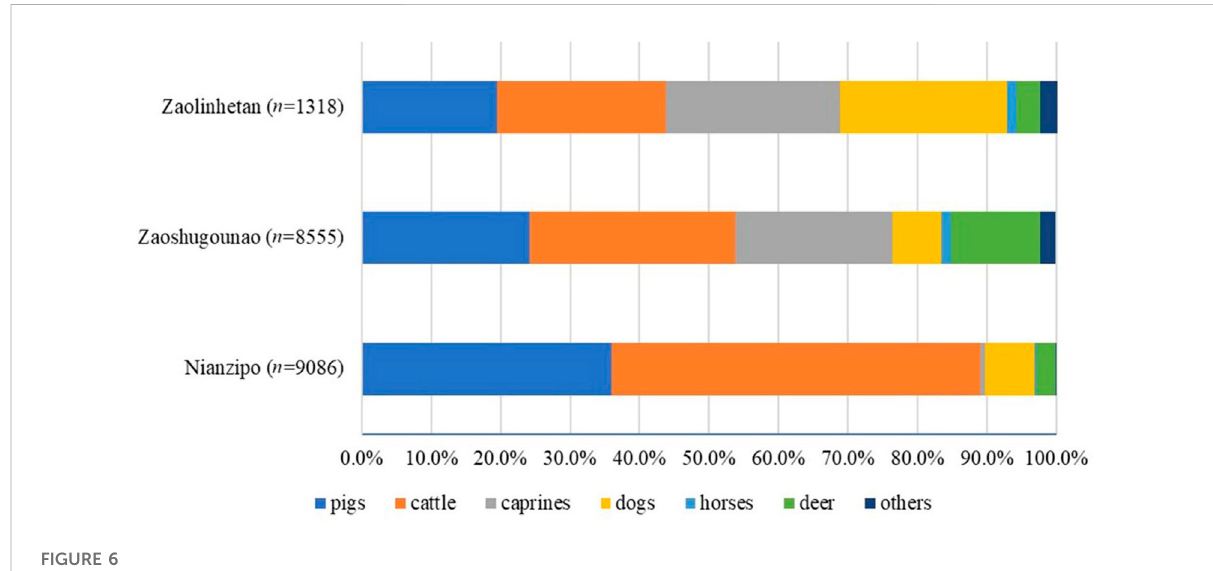
FIGURE 6 NISP% of animal remains from Nianzipo, Zaoshugounao, and Zaolinhetan.